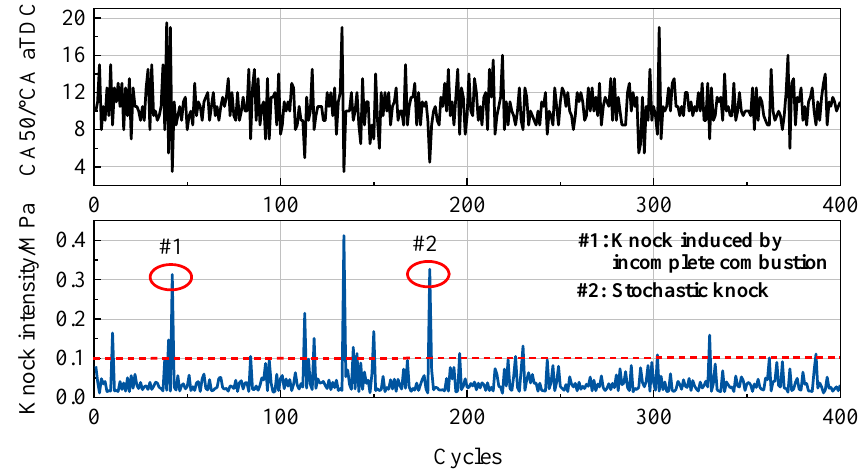
Figure 8. Engine performance at HCCI high load boundary conditions (1500 r/min, IMEP = 0.4 MPa).